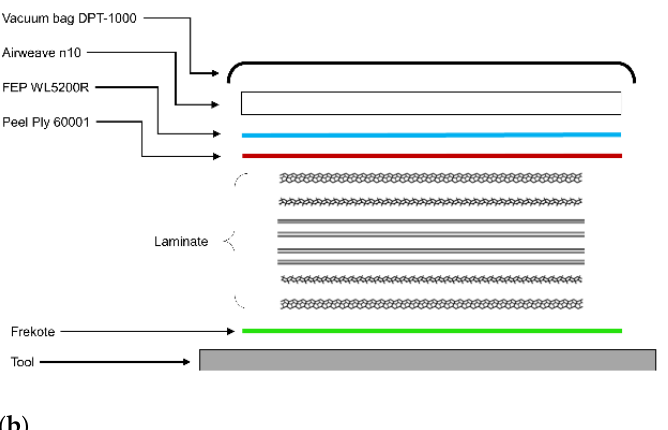
Figure 1. ( a ) Photograph showing the automated tape laying process of the laminated panels; ( b ) diagram of the vacuum bag.